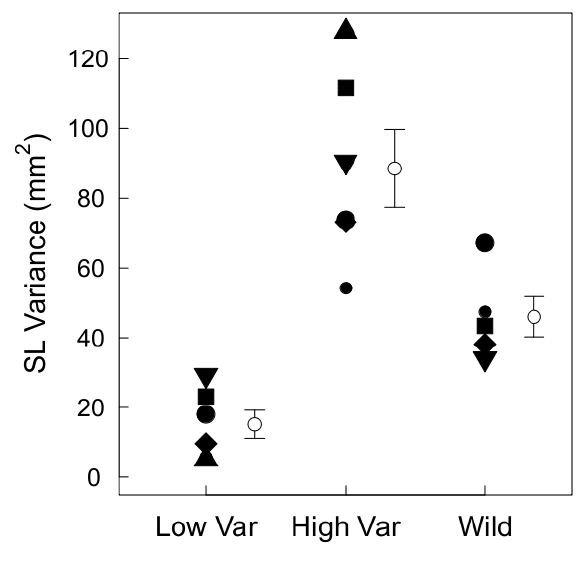
Figure 1. Variance in standard length of threespine stickleback in the high (HV) and low size variance (LV) enclosures. For comparison, we show variances for samples of wild-caught fish from outside the five of the six blocks. Symbols represent spatial blocks and can be compared with Figs. 2, 4 and 5, and error bars indicate + 1 SE.